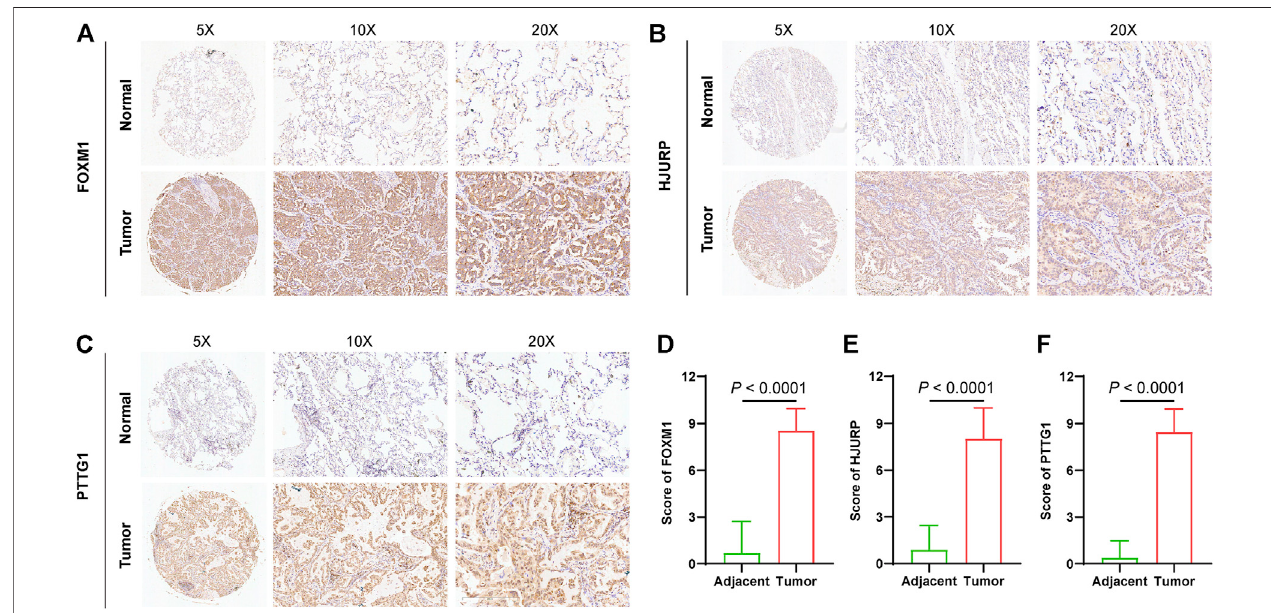
FIGURE8| ValidationofsignaturegeneexpressionsinLUADtissues.Quanti fi cationandcomparisonofproteinexpressionofFOXM1 (A and D) ,HJURP (B and E) , and PTTG1 (C and F) by IHC.